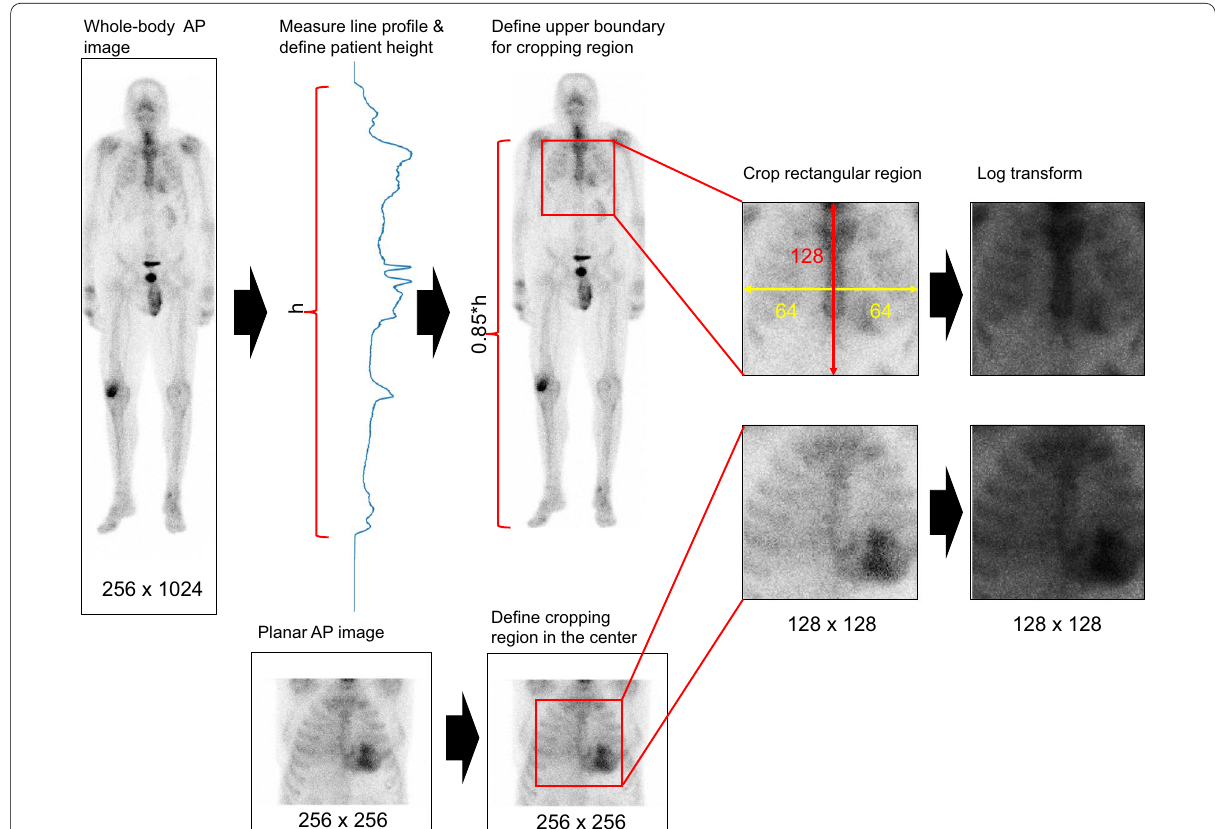
Fig. 2 Preprocessing workflow for whole‑body and thoracic planar